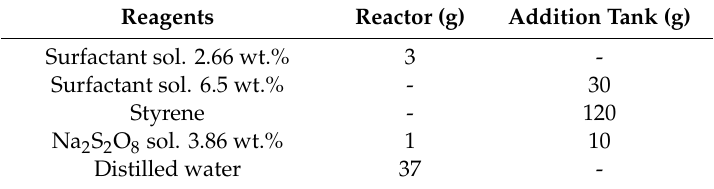
Table 2. Polystyrene formulation for the semicontinuous emulsion